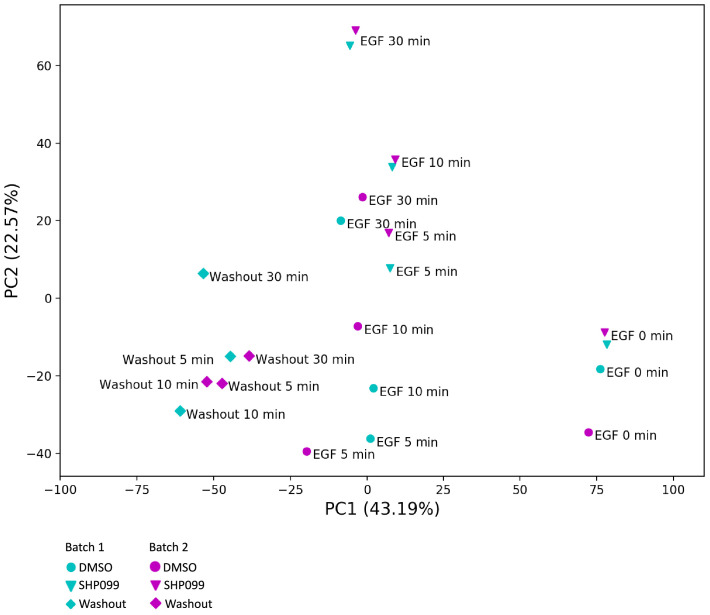
Principal component analysis.Paired samples from two independent biological replicates are shown. Each datapoint represents a treatment condition in the TMT 11-plex experiment as indicated in the legend. The first two principal components are plotted, and the explained variance of each component is indicated in parentheses.